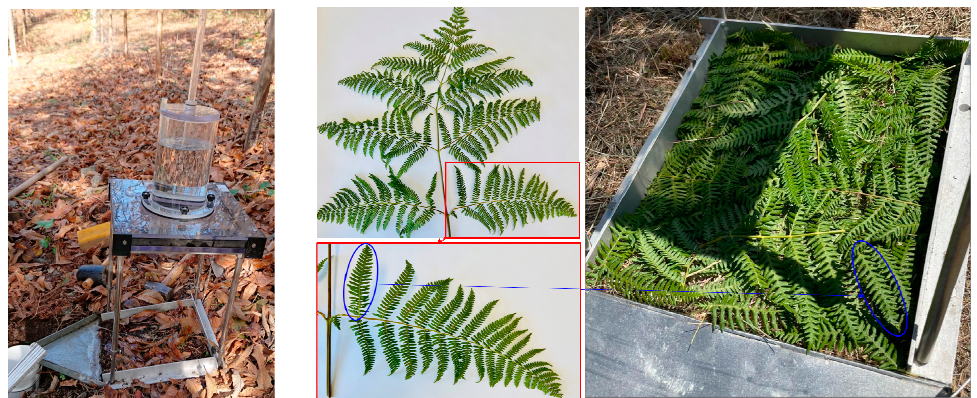
Figure A3. Measurements of soil hydraulic conductivity (using a portable rainfall simulator) and fern mulch application into the rainfall simulator at the experimental site (Samo, Calabria, Southern Italy).